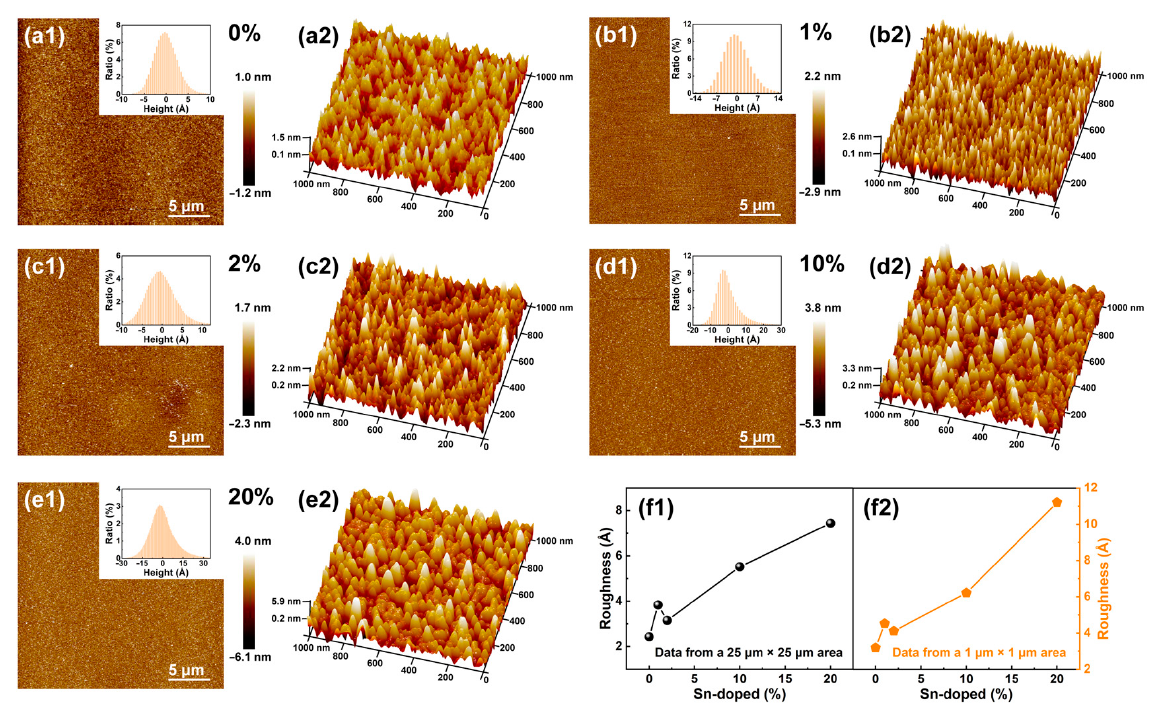
Figure 3. AFM images of the 2D morphology of annealed Ga 2 O 3 thin films with ( a1 ) 0%, ( b1 ) 1%, ( c1 ) 2%, ( d1 ) 10%, and ( e1 ) 20% Sn content. The corresponding height distribution images are shown in the inset of ( a1 – f1 ). ( a2 – e2 ) The AFM representations of the 3D morphology by narrow scans with different Sn content. ( f1 , f2 ) The corresponding average RMS roughness of the films.